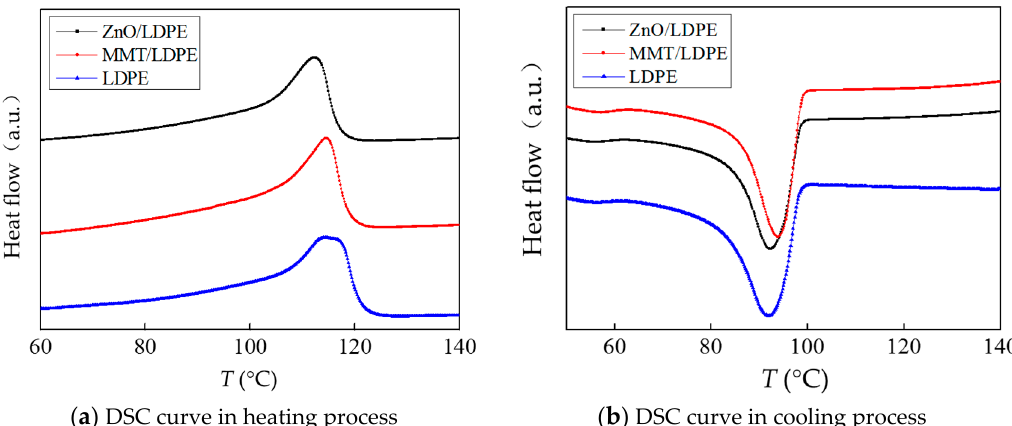
Figure 6. Heating and cooling curve of low density polyethylene (LDPE), MMT/LDPE and ZnO/LDPE samples. Table 2. Isothermal crystallization and melting parameters of ZnO/LDPE, MMT/LDPE and LDPE. Sample